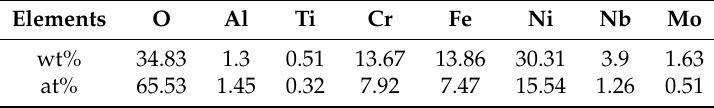
Table 4. Oxide analysis at crack tip in 718Plus